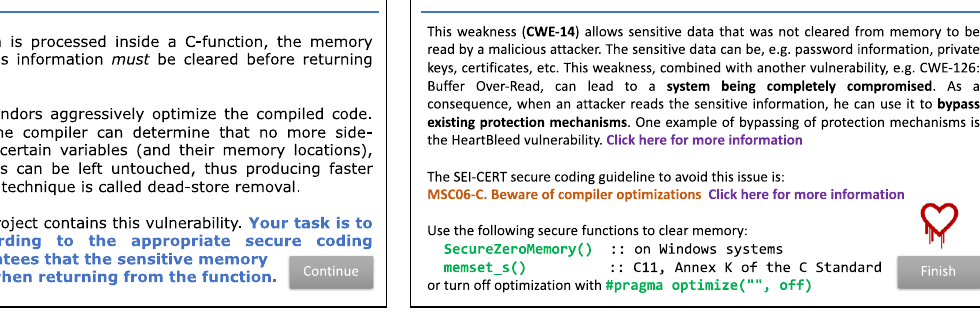
Fig. 9 CWE-14 Challenge: Introduction and Conclusion